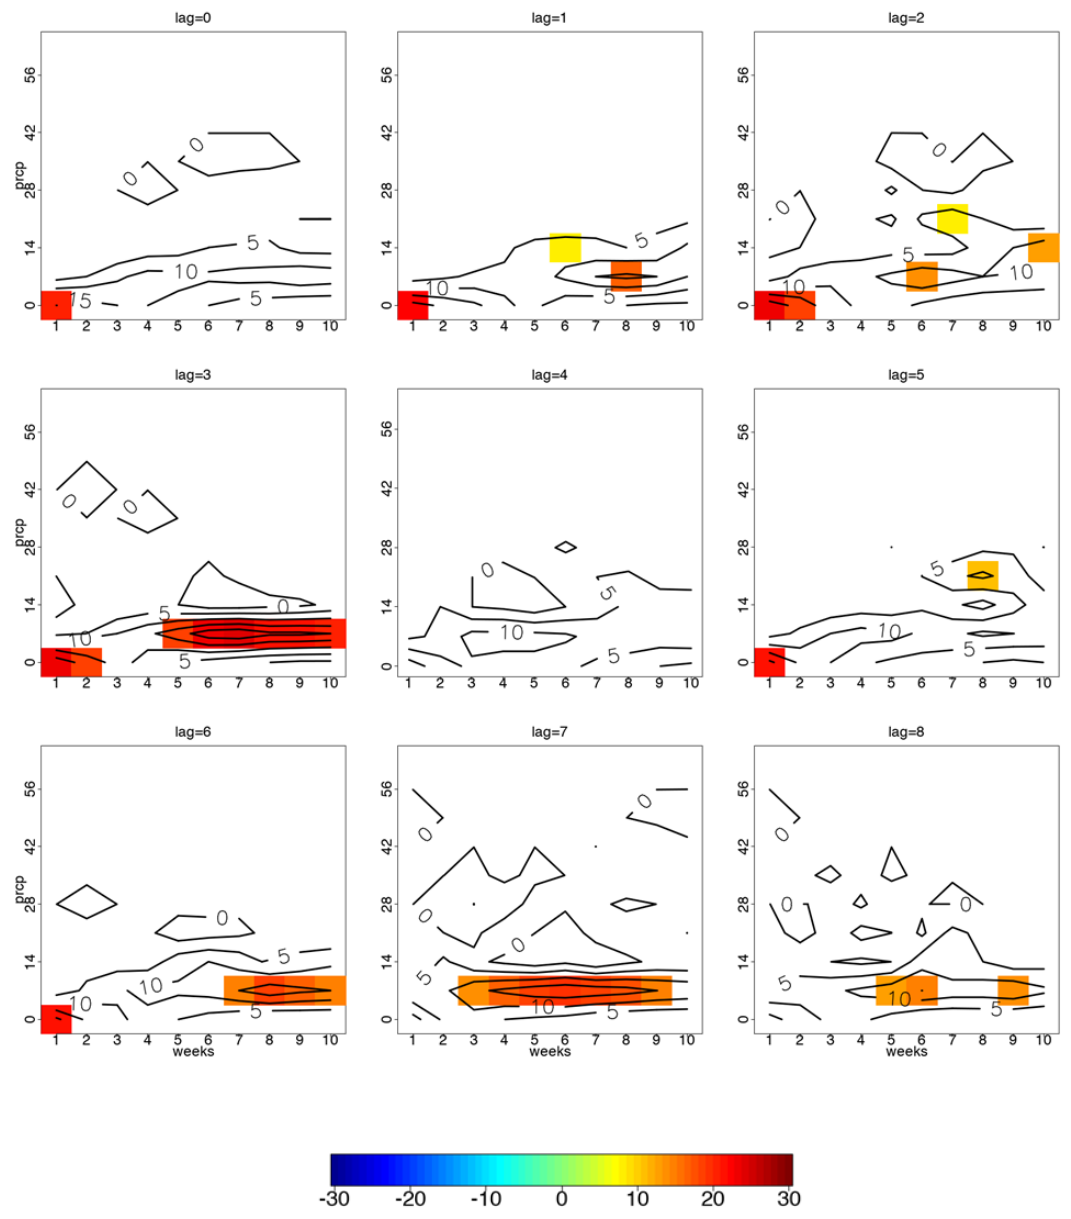
Figure 5. Statistically significant contour differences in anomalously high and low diarrhoea case counts for lag 0 to 8 weeks per consecutive weeks of precipitation among individuals under 5 years of age for season JJA. X-axis represents number of consecutive weeks in which the average precipitation reached over Y-axis representing rainfall in millimetres (mm). Warm colours represent higher frequency of (X, Y) occurring when diarrhoea case counts were anomalously higher than average.